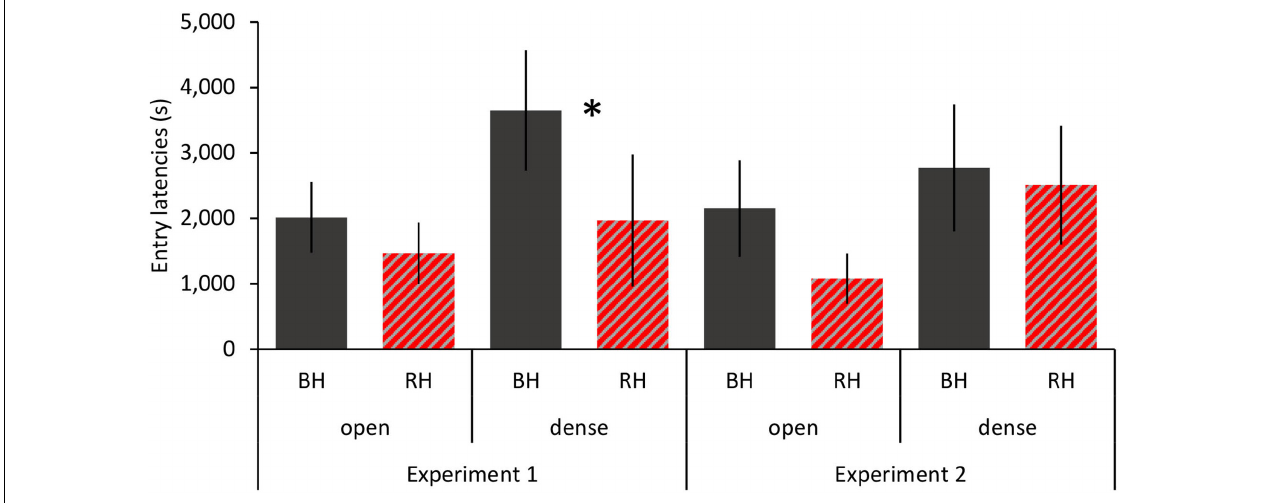
FIGURE 3 | Effects of habitat type, head color and experiment on entry latencies of Gouldian finches to unfamiliar habitats. The experimental setup was the same as in Figure 2 . Mean and SE for entry latencies into open and dense habitats for experiments 1 and 2 and the two head colors. Cut-off points for entry latencies were 10,800 s (3 h). Black bars: black-headed birds (BH), striped red and gray bars: red-headed birds (RH). * p < 0.05.